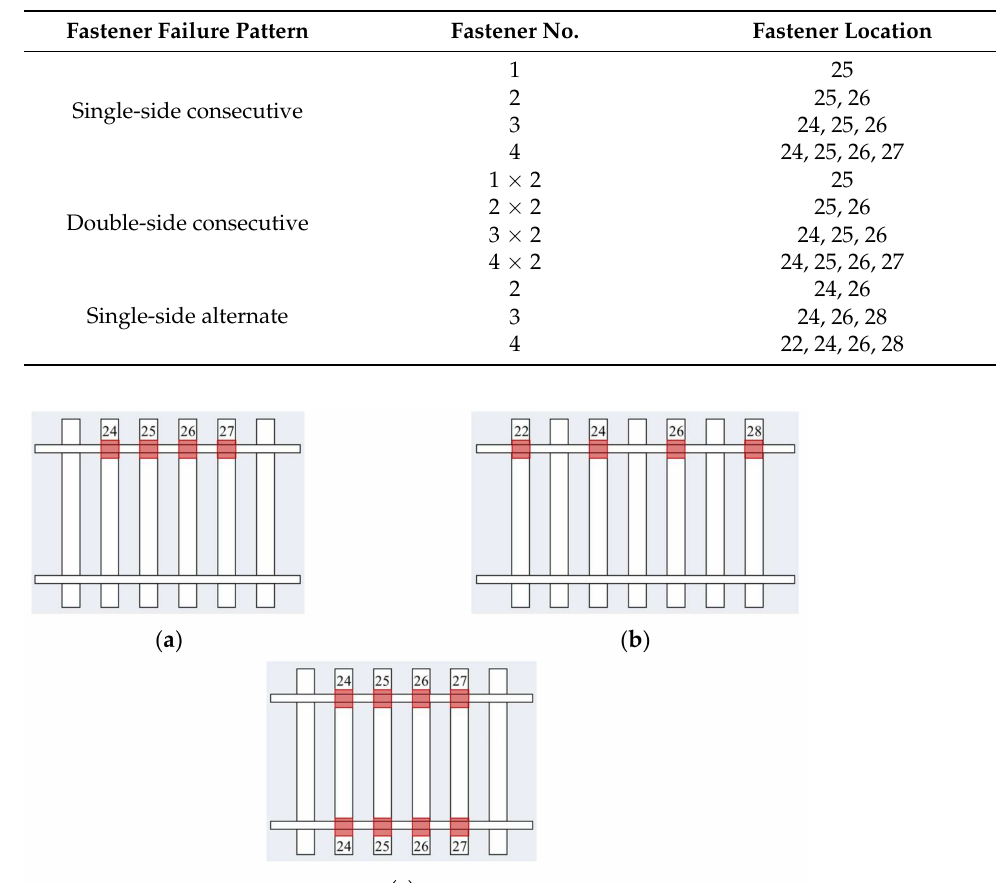
Table 6. The calculation details of three different scenarios of rail fastener failure.